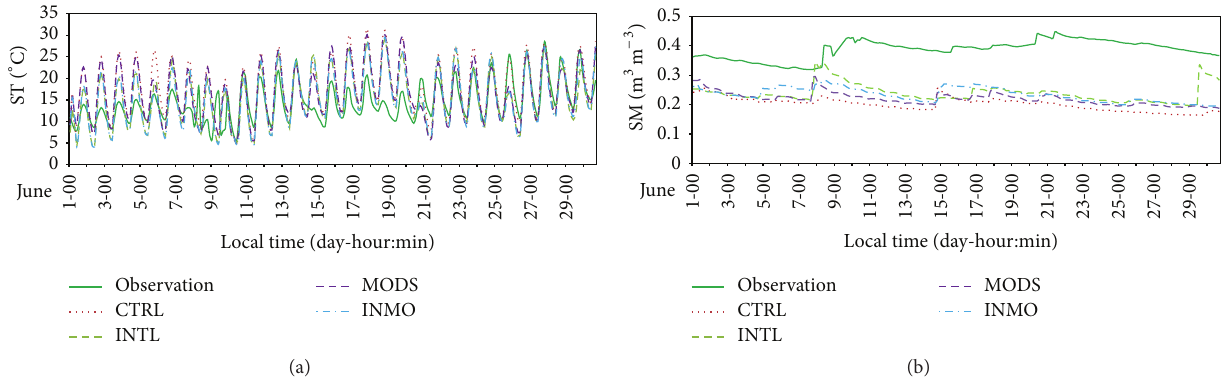
Figure 5: Comparison of modeled and observed 10 cm soil temperature and moisture at Arou station: (a) soil temperature (ST) and (b) soil moisture (SM).